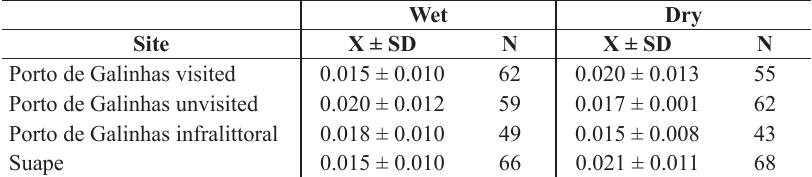
Samplings (N), means and standard deviations (X ± SD) of Palythoa caribaeorum growth rate (cm.day -1 ) from Porto de Galinhas and Suape beachrocks.